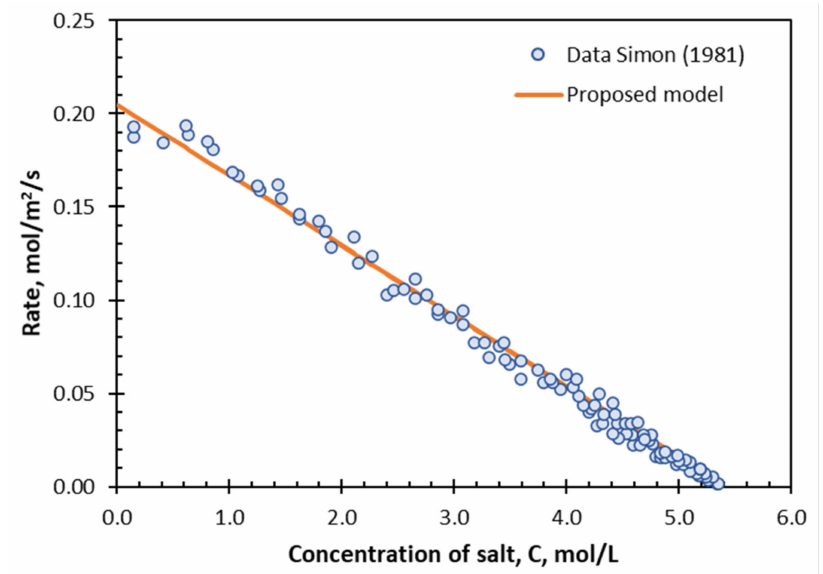
Figure 8. The linear relationship between the rate of dissolution and the concentration of salt for NaCl for salt concentrations between close to zero and saturation. The line represents the surface-vacancy model. Data from Simon [73], see also Crundwell [8].